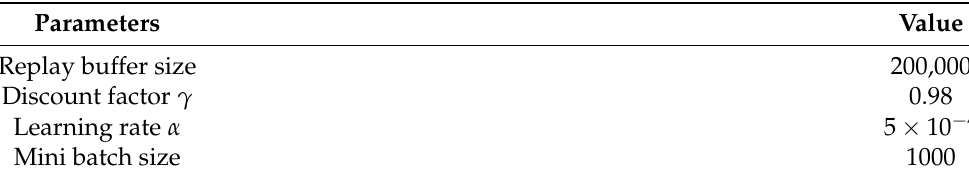
Table 3. Hyperparameters of the multi-layer RL